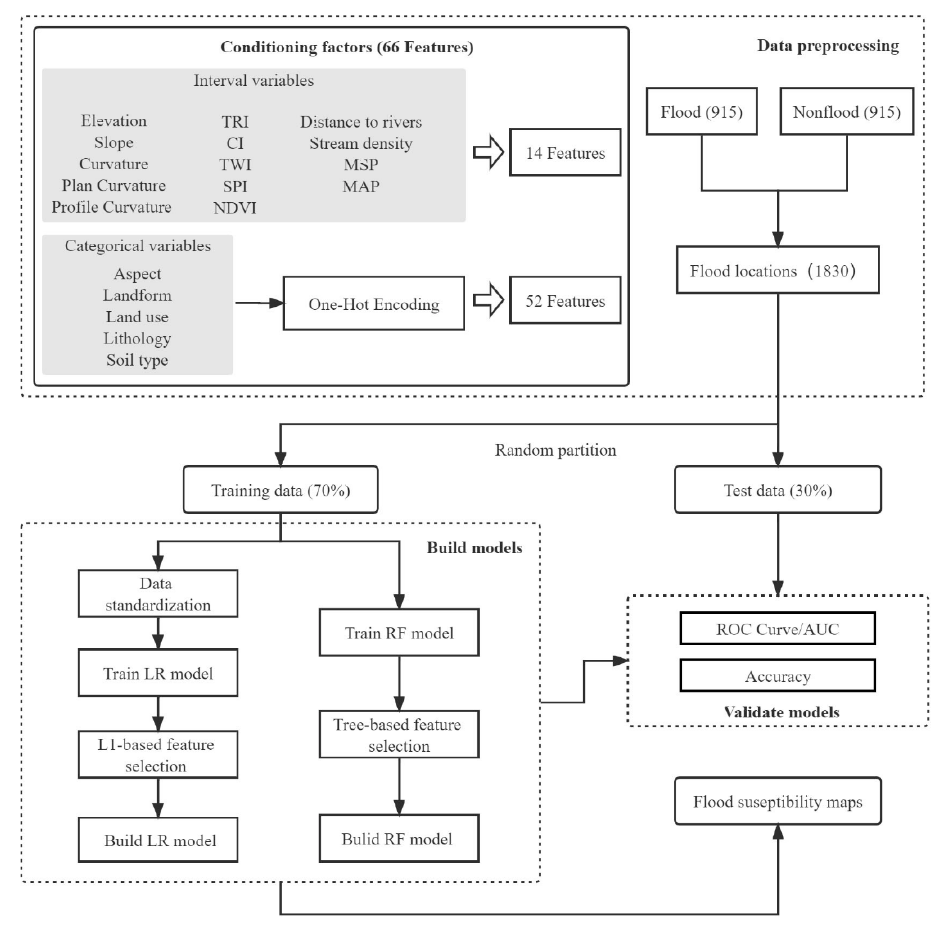
Figure 4. Flowchart of the methodology adopted in this study.